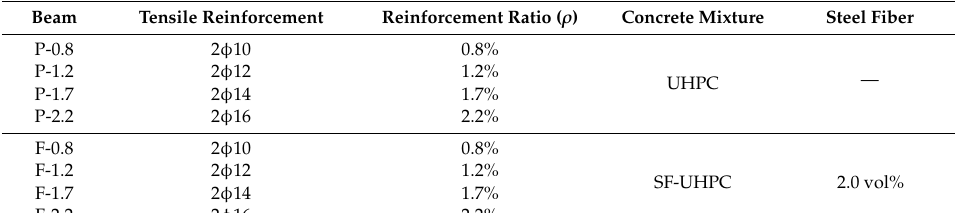
Figure 3. A typical singly reinforced concrete test beams.